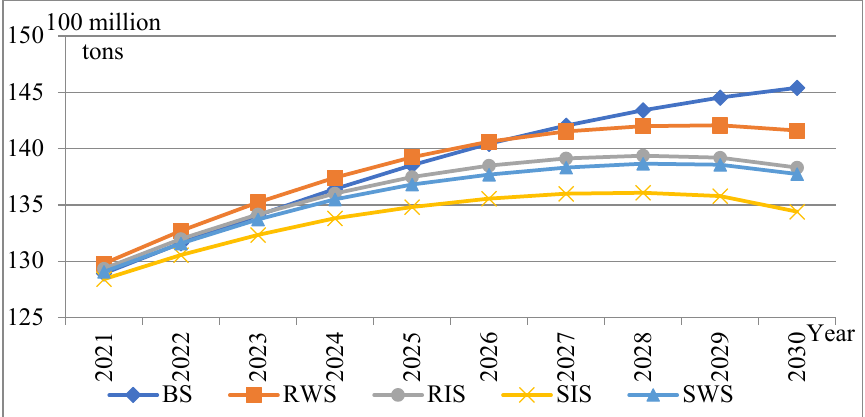
Figure 3. Predicted carbon emissions in China in 2021–2030.